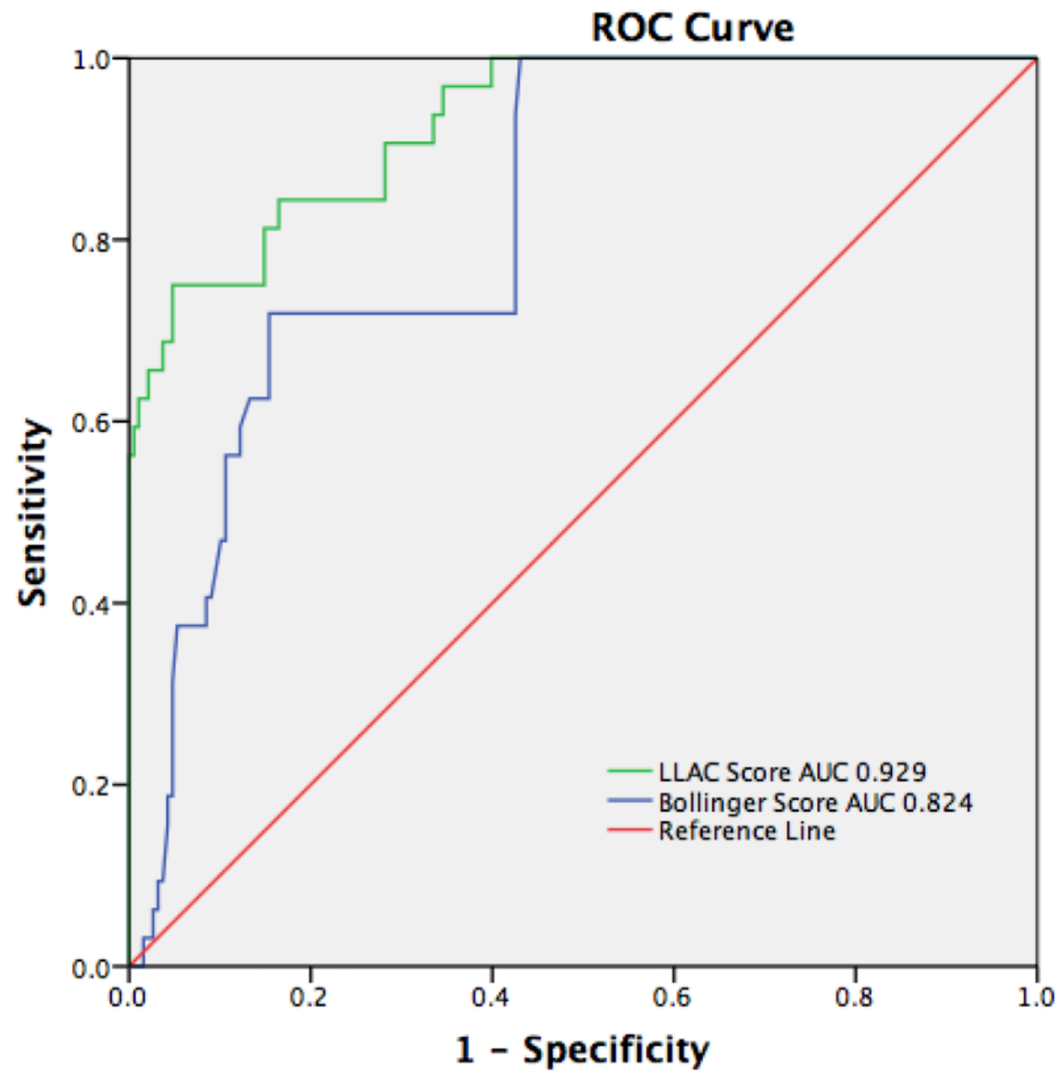
Fig 4. Receiver-operator curves for total LLAC and Bollinger scores and the primary outcome of cardiac mortality and morbidity. AUC for the LLAC score was 0.929 (95% CI 0.884–0.974), p < 0.001 AUC for the Bollingerscore 0.824 (95% CI 0.758–0.890), p < 0.001ROC = receiver-operator curve; LLAC = lower limb arterial calcification;AUC = area under the curve; CI =